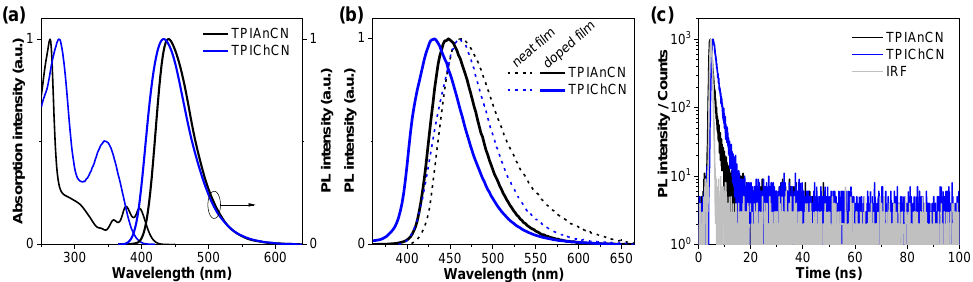
Figure 3. ( a ) UV-Vis absorption and PL spectra in toluene (~10 − 5 M). ( b ) PL spectra of the neat films and 5wt% doped in CBP films coated on fused silica substrates. ( c ) Transient PL spectra in neat films. Table 1. Key optical and physical data of TPIAnCN and TPIChCN in solution and thin